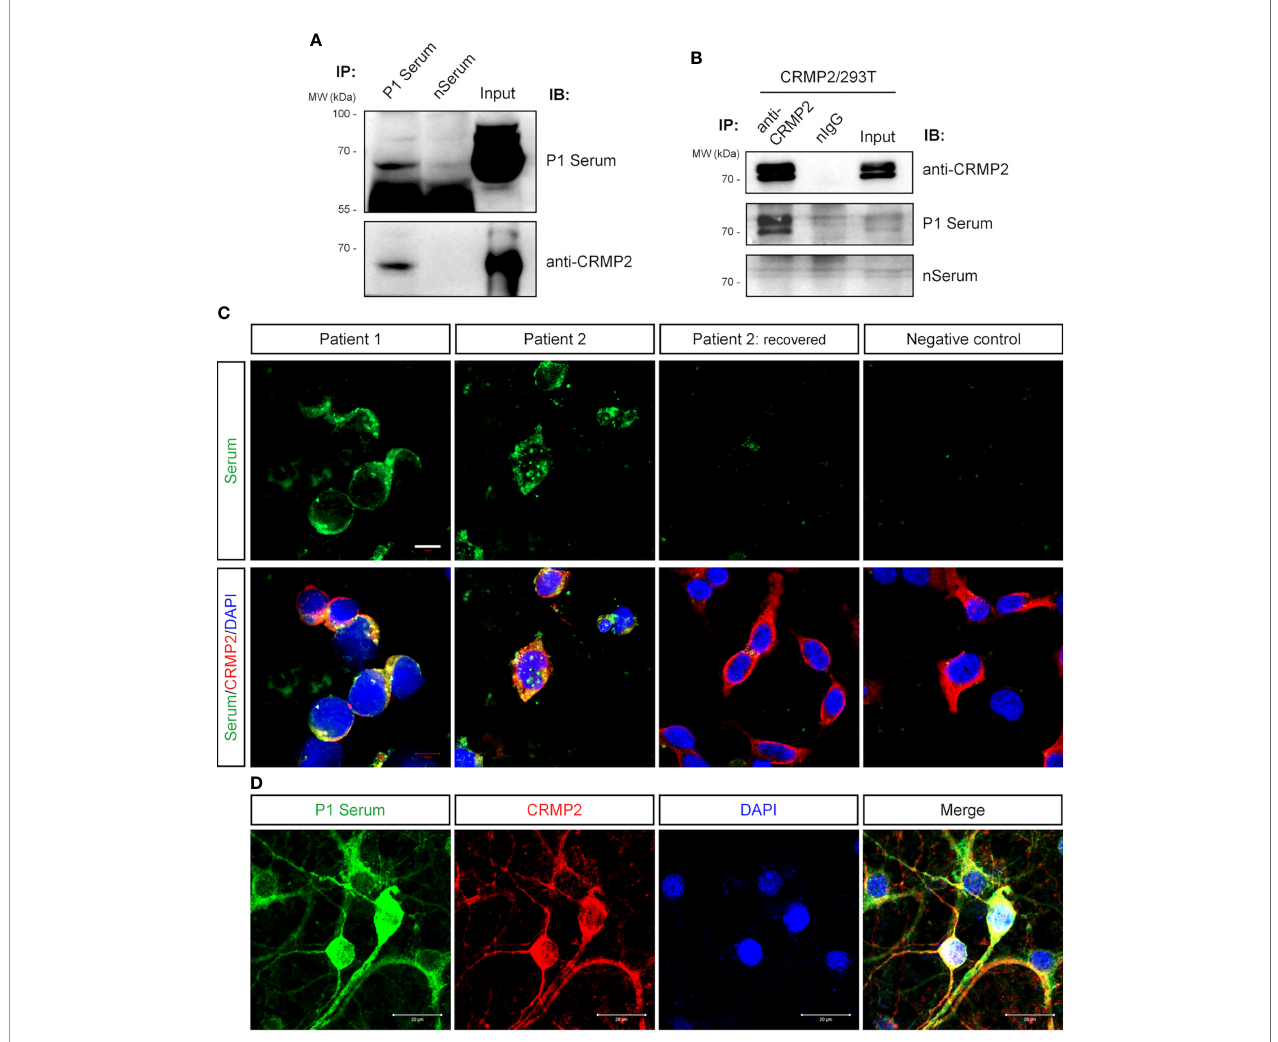
FIGURE 4 | Veri fi cation of anti-CRMP2 antibody. (A) IP with P1 patient ’ s serum was performed with rat brain protein lysate. Immunoblottings were done with P1 patient ’ s serum (upper panel) andcommercial anti-CRMP2 antibody (lower panel). (B) IP with commercial anti-CRMP2 antibody was performed with HEK293T cells overexpressing full-length human CRMP2 (isoform1). Anti-CRMP2 antibody, P1 patient, ornegative control sera were used for Westernblotting, separately. (C) CRMP2-expressing HEK293T cells were immunostainedwith the patients ’ sera andanti-CRMP2 antibodies. The sera fromthe fi rst collection ofP1 andP2 patients showed positive staining and co-localized with CRMP2. Serum collected from P2 patient 1.5 yearsafter recoveryshowed negative staining. (D) Colocalization of P1 patient ’ s serum andanti-CRMP2 Ab immunostaining in cultured mouse cortical neurons. CRMP2, collapsin response mediatorprotein 2; DAPI, 6-diamidino-2-phenylindole; IB, immunoblotting; nIgG,normal immunoglobulin G; IP, immunoprecipitation;WB, Western blotting. Scalebars represent 10 m m in (C) and 20 m m in (D)